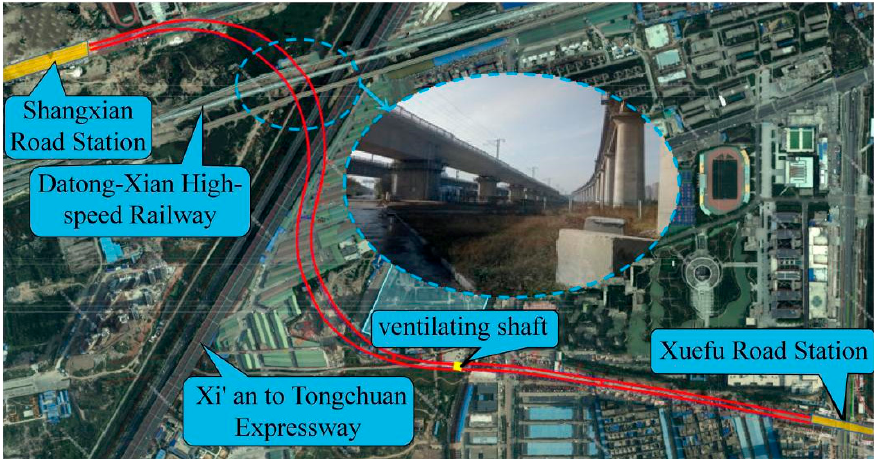
Figure 1. Location relationship between the Shang–Xue interval and the high-speed railway bridge.